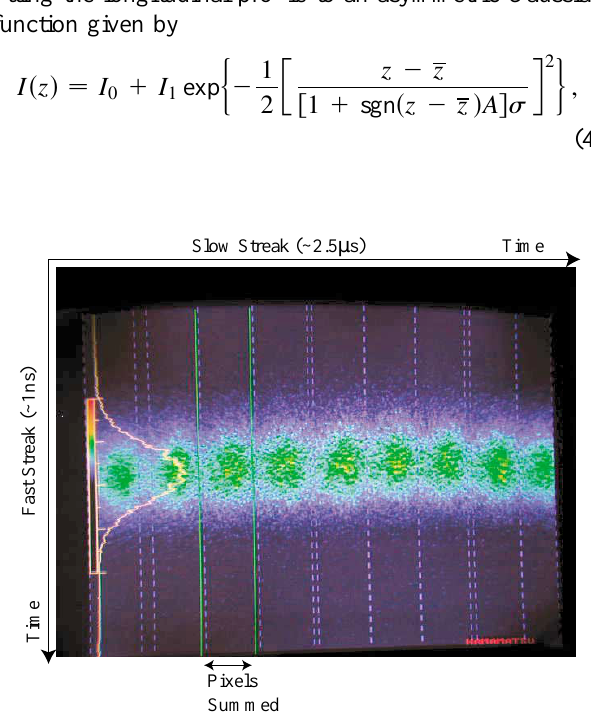
FIG. 7. (Color) This is a sample image of nine positron trains in CESR. Taking a vertical slice and summing the pixels between the slices gives the longitudinal profile shown to the left. The green lines denote the vertical slice that is the summed train. The profile of the distribution is displayed to the left. A profile of the train is displayed in Fig. 13 where the distributions are fit to a Gaussian function. For this image, nine longitudinal profiles were